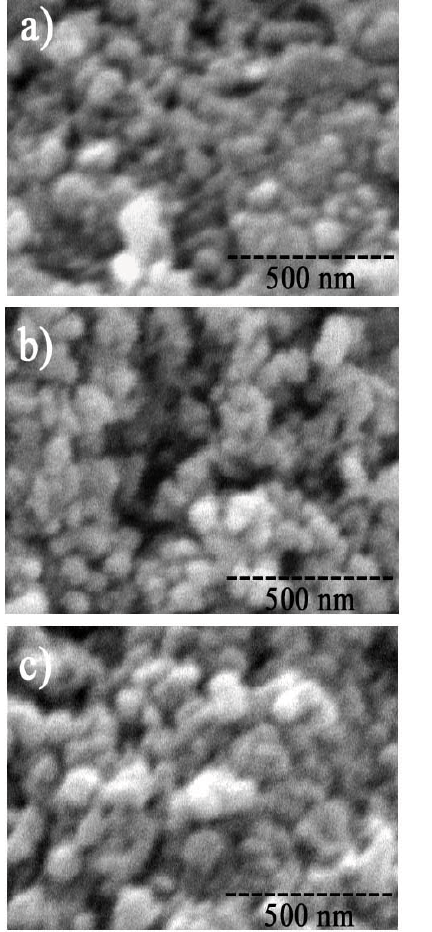
Figure 7. SEM images of La Ca MnO powders prepared by the modified citrate gel precursor method and calcined at a) 520°C, b) 650°C and 0.6 0.4 3 c) 750°C for 2